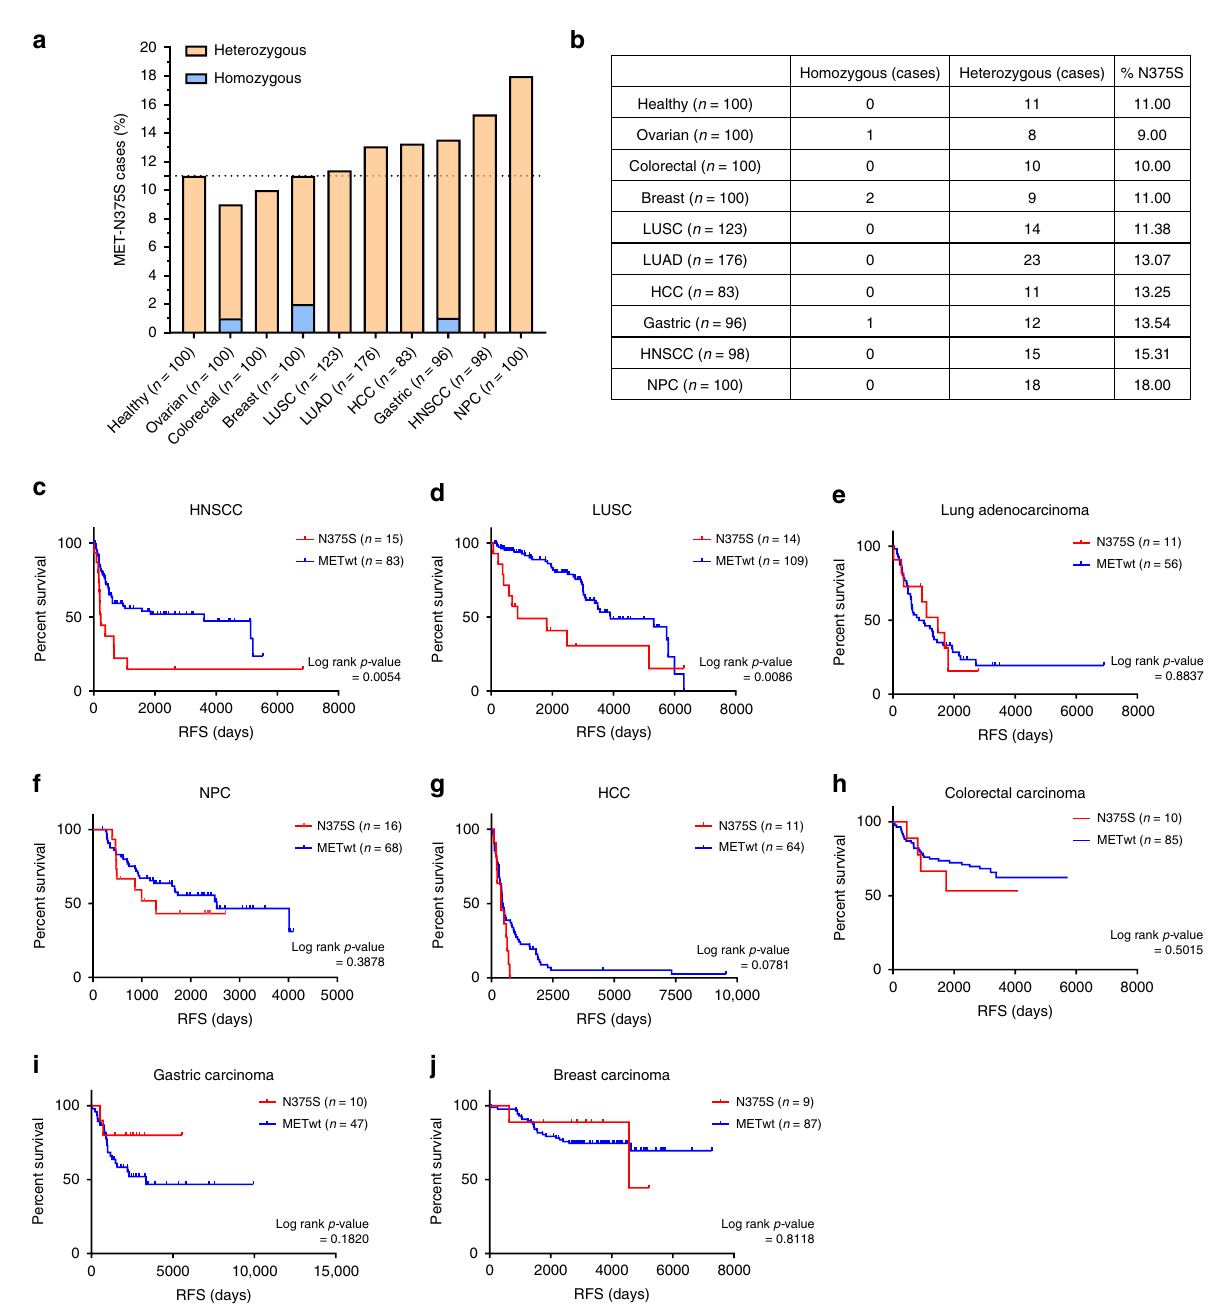
Fig. 1 MET N375S mutation correlates with poorer relapse-free survival (RFS) in LUSC and HNSCC patients. a , b Germline DNA from healthy volunteers and cancer patients, part of a Pharmacogenetics database with germline DNA derived from blood and with clinical follow-up data available, were sequenced with ddPCR using MET N375N (WT) and N375S-speci fi c probes to determine the distribution and frequency of MET (N375S) genotype in Asian population. Graph ( a ) and table ( b ) showing the percentage and number of N375S + cases (heterozygous or homozygous) among healthy volunteers and cancer patients. c – j Relapse-free survival (RFS) of patients with locally advanced diseases who had undergone concurrent chemoradiotherapy or surgery were analyzed with Kaplan – Meier method and log-rank test. RFS (measured from time of treatment/surgery to relapse) for head and neck squamous cell carcinoma ( c ), lung squamous cell carcinoma ( d ), lung adenocarcinoma ( e ), nasopharyngeal carcinoma ( f ), hepatocellular carcinoma ( g ), colorectal carcinoma ( h ), gastric carcinoma ( i ), and breast carcinoma ( j ). Subjects who have not reached study-de fi ned endpoint were censored (tick marks) from the analysis (Data cutoff point: January